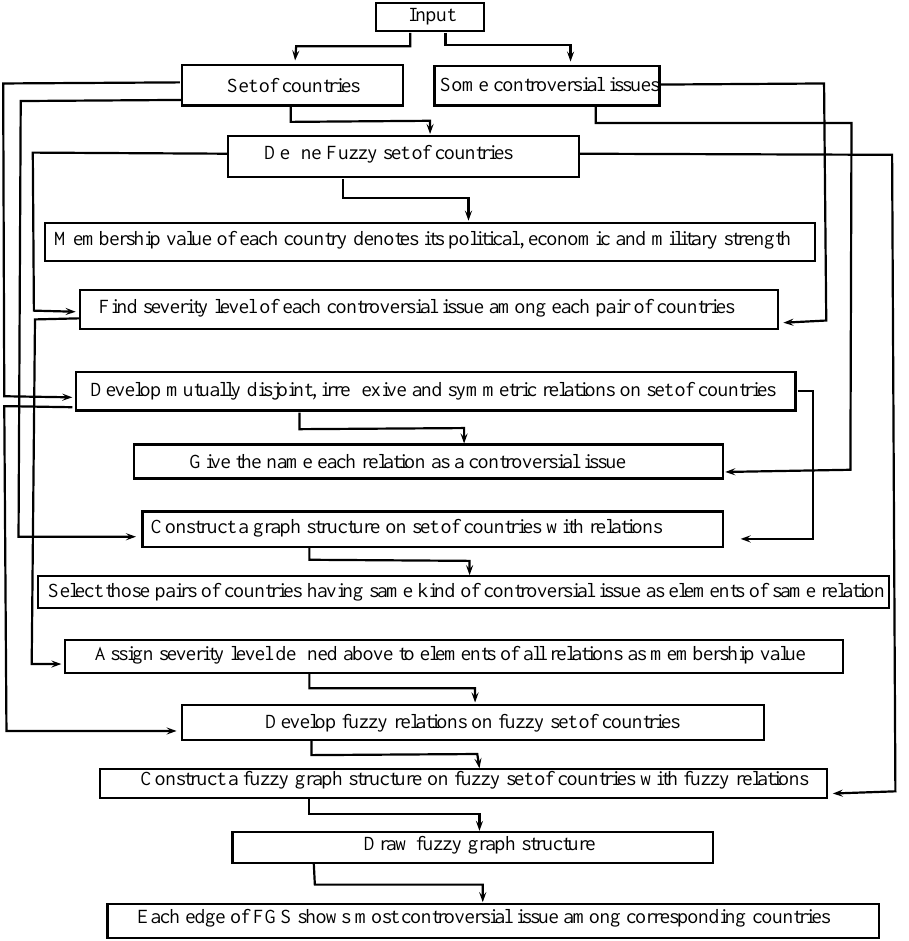
Figure 16: Flowchart Figure 16.